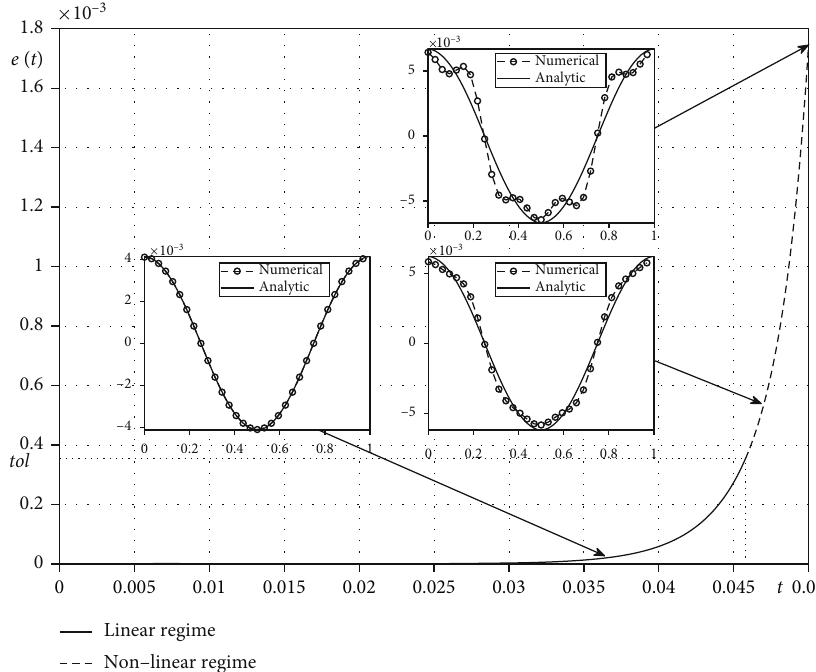
Figure 7: Temporal evolution of error e ð t = n Δ t Þ for mode K = 2